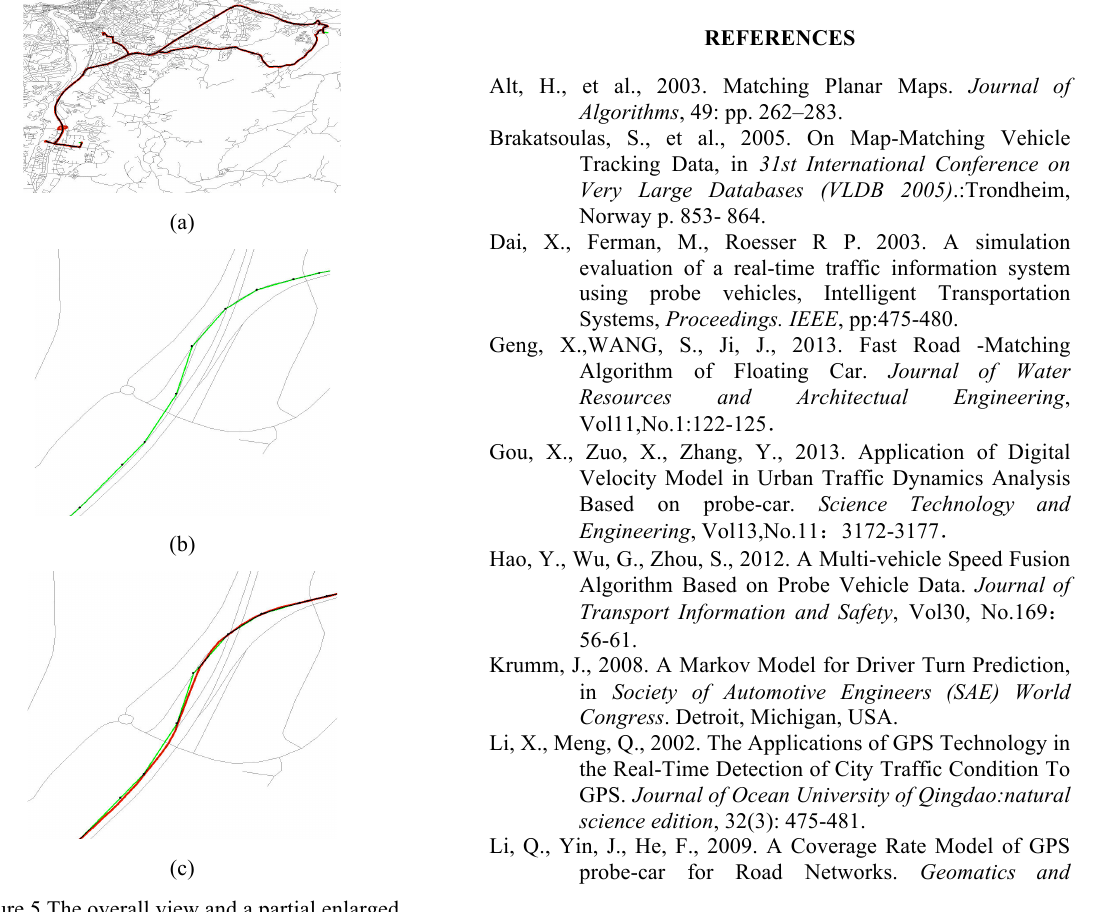
Figure 5 The overall view and a partial